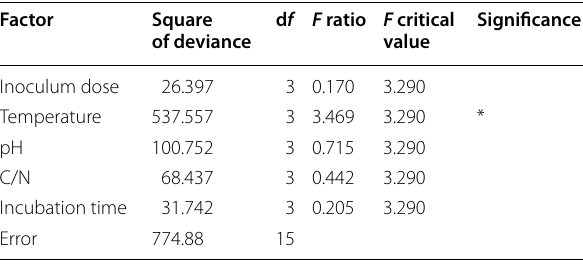
Table 4 Variance analysis for the conditions of NH degradation